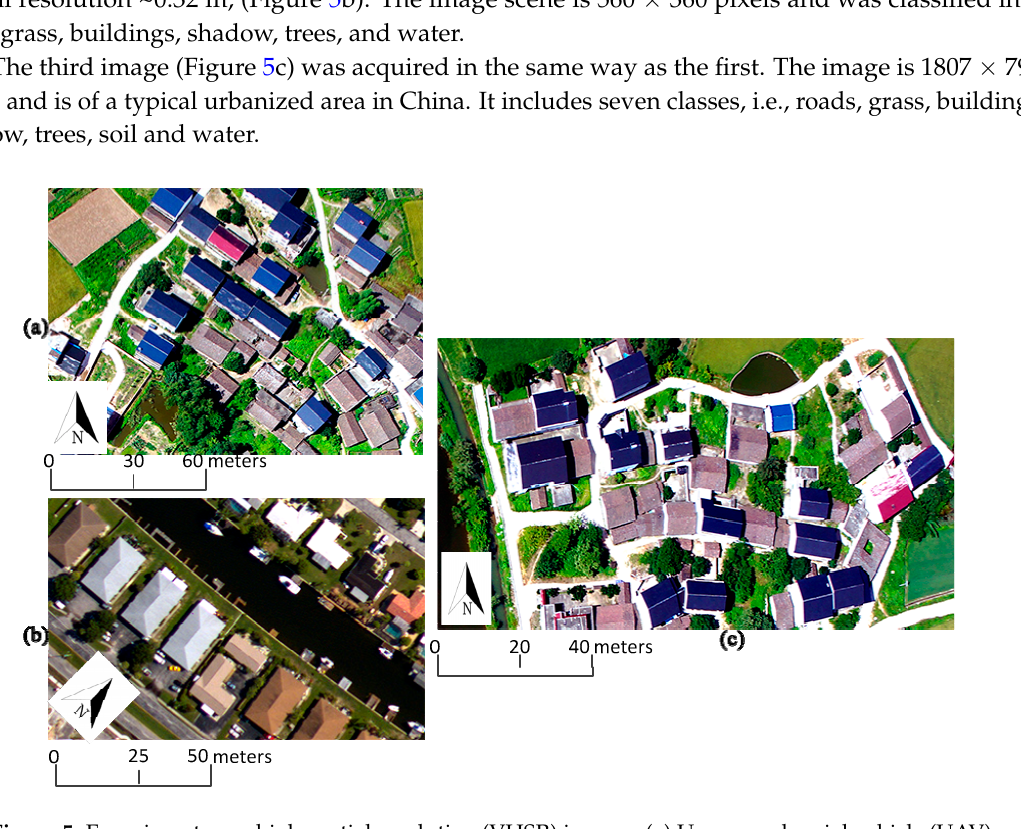
Figure 5. Experiment very high spatial resolution (VHSR) images: ( a ) Unmanned aerial vehicle (UAV) image for experiment-1; ( b ) aerial image for experiment-2; ( c ) UAV image for experiment-3.